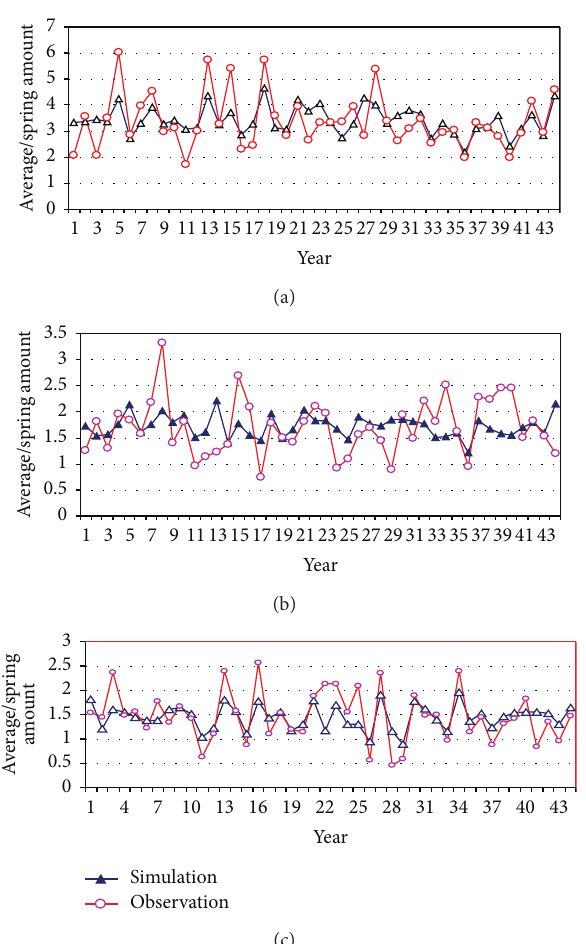
Figure 5: Observed and simulated mean seasonal precipitation (1958–2001) with predictors, the first 10 PCs—MEOF (G-850hPa and pp) for three stations: (a) Ljubljana ( 𝑅 = 0.69 ), (b) Wien ( 𝑅 = 0.23 ), and (c) Turnu Magurele ( 𝑅 = 0.74 ).